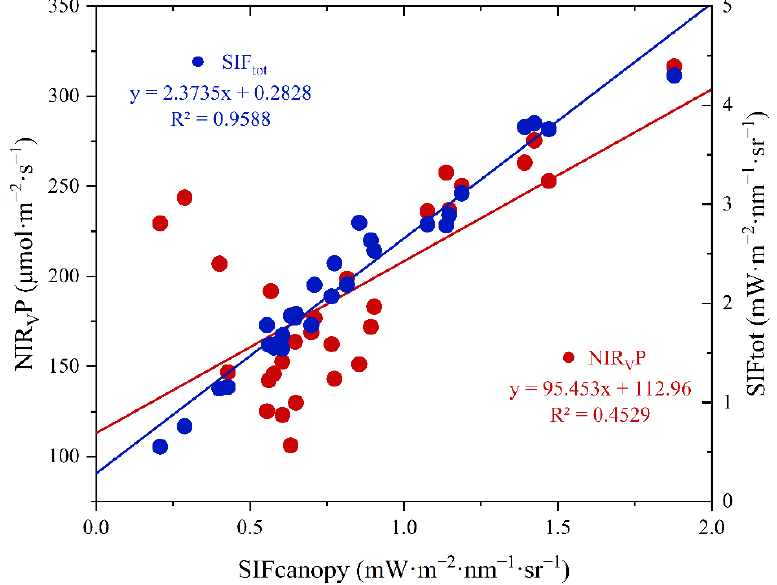
Figure 4. Overview of the relationships between SIF canopy and SIF canopy -related variables in the severe stage of disease onset ( n = 29). severe stage of disease onset ( n =